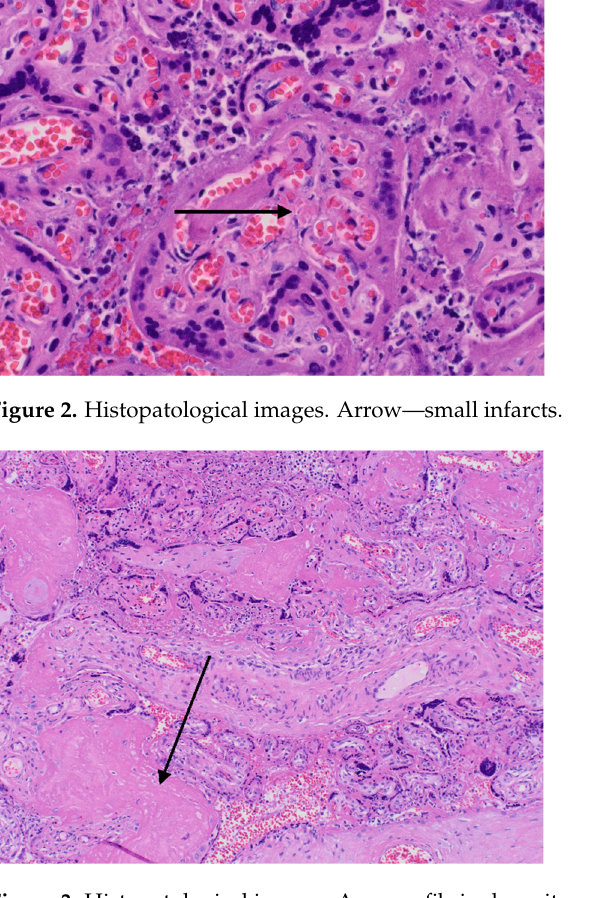
Figure 3. Histopatological images. Arrow—fibrin deposits. Table 2. The newborn’s examination results.